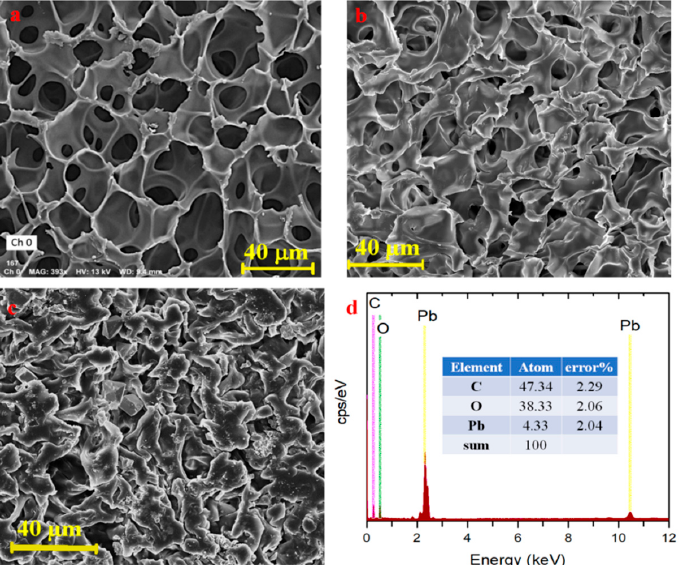
Figure 6. HRSEM images of the pure PVF foam ( a ), PVF/GO ( b ), PVF/GO foam loaded with Pb ions ( c ), and elemental mapping of the PVF/GO foam loaded with lead ions ( d ). Inset: The energy-dis- persive X-ray (EDX) elemental analysis of PVF/GO foam loaded with lead